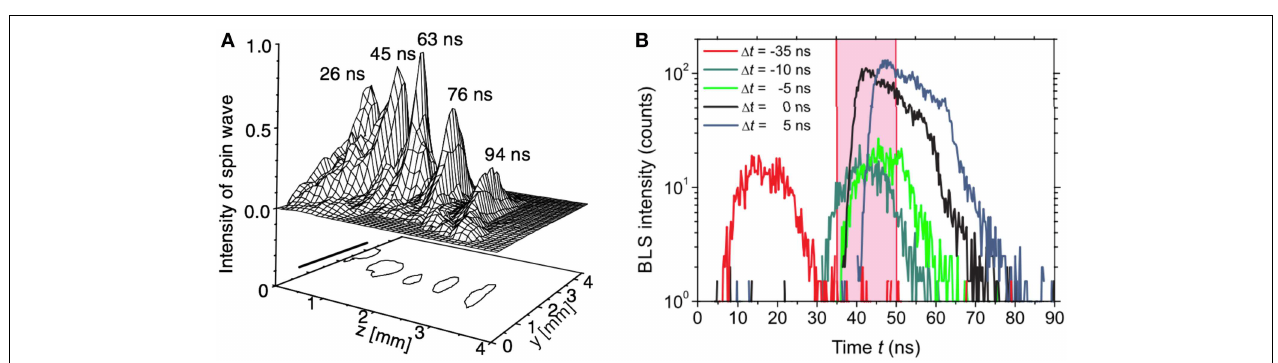
FIGURE 15 | (A) Temporal evolution of the self-focusing of a two-dimensional spin-wave bullet in an yttrium iron garnet film [56]. (B) Time-resolved BLS measurement of spin-wave pulses amplified via parametric pumping in a microstructured Ni 81 Fe 19 waveguide [124].